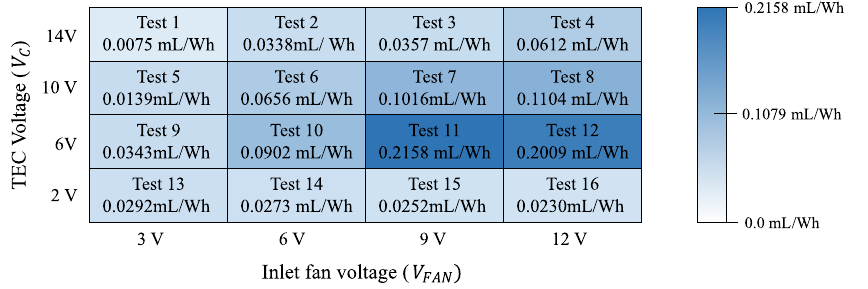
Figure 13. Color map of the system performance space.